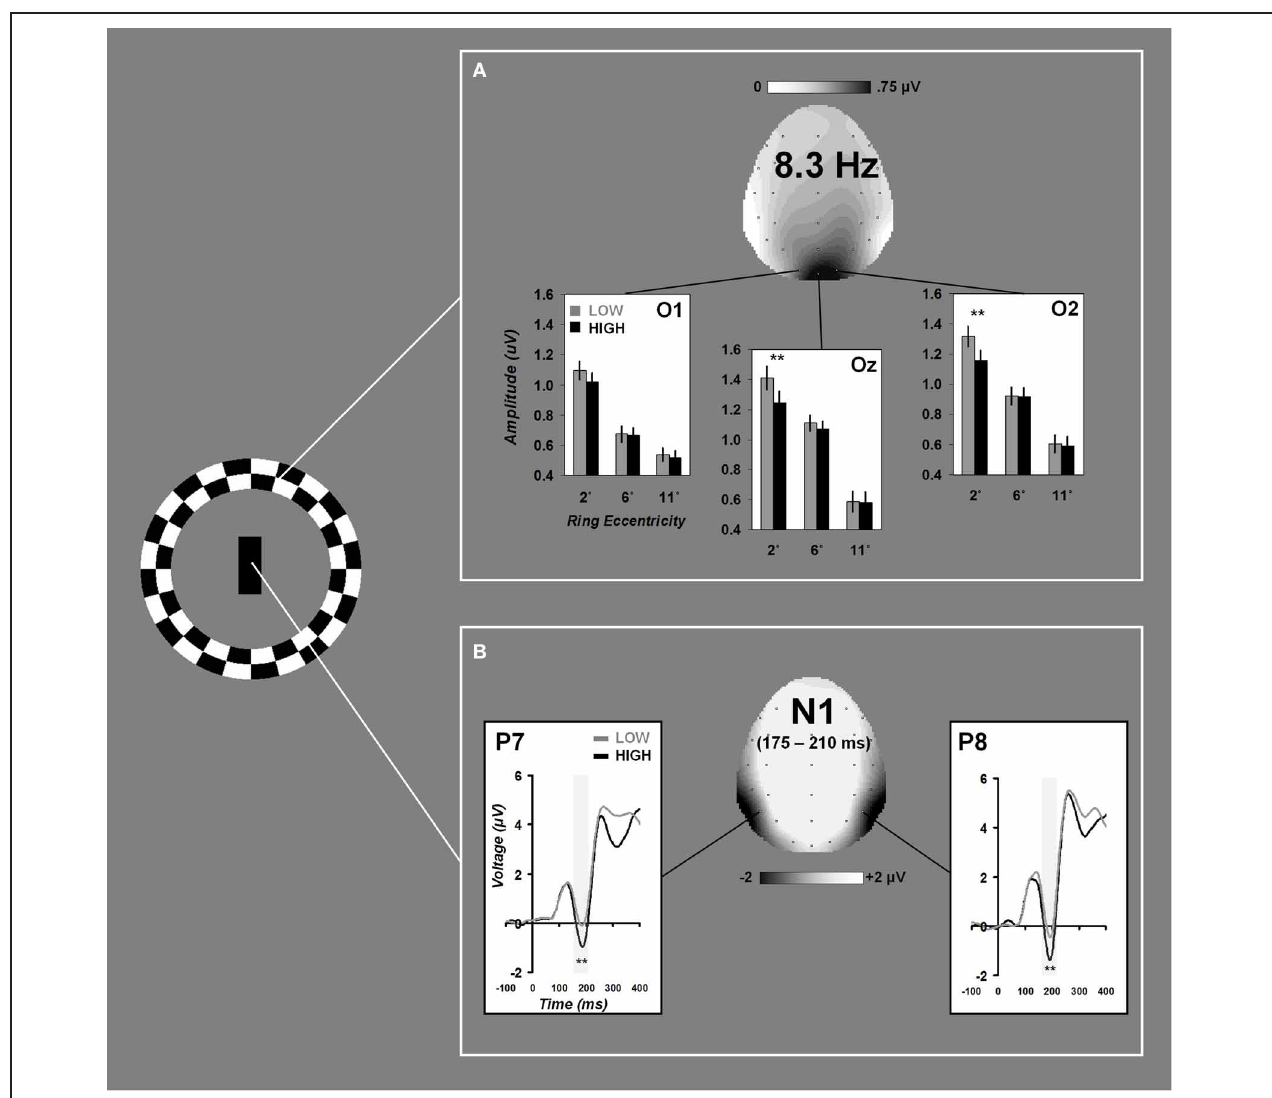
FIGURE 3 | Load-dependent effects on distractor and task-relevant visual processing. Grand average effects of attentional load on 8.3Hz peripheral distractor amplitudes are plotted for electrodes O1, Oz, and O2 in (A) . Grand